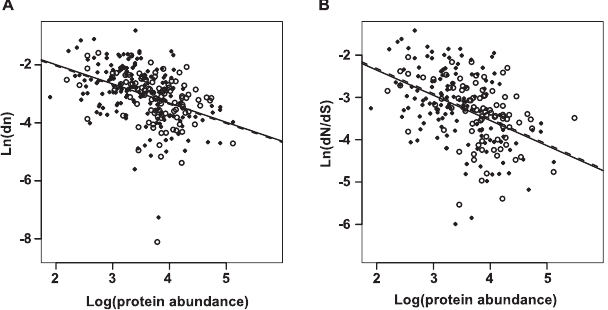
Figure 5. Date and Party Hubs Evolve at the Same Rate When Controlled for Protein Abundance The relationship between dN (A) and dN/dS (B) as a function of protein abundance was determined for party hubs (open circles) and dates hubs (filled circles). Best-fit lines assuming equal slopes for the two hub types are shown (party hub, dashed line; date hub, solid line). DOI: